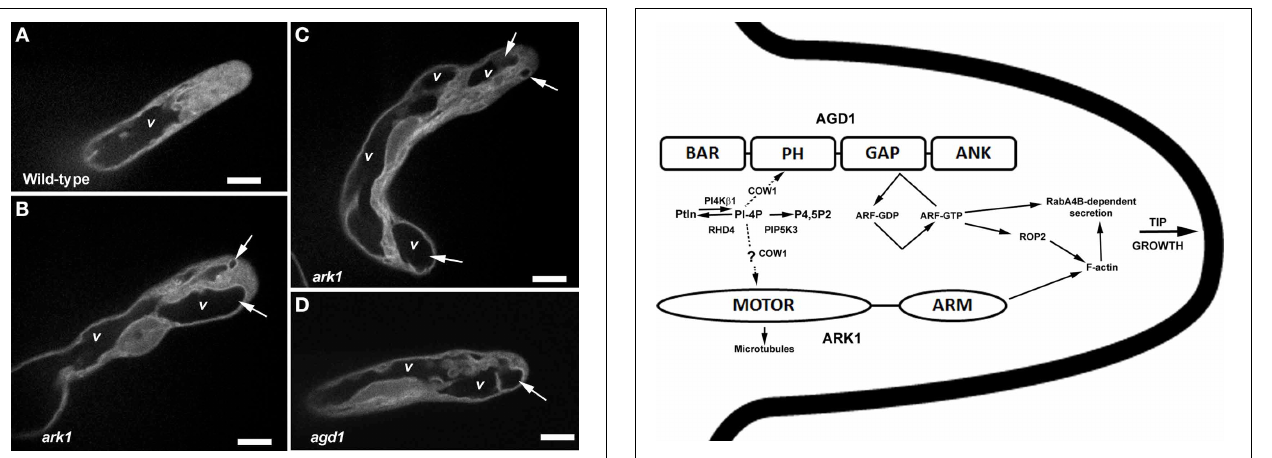
FIGURE 6 | Abnormal tonoplast organization at the growing apex was observed in ark1 and agd1 root hair cells. Tonoplast was visualized by expressing GFP-TIP in the plants. (A) In wild-type, the vacuole ( v ) is maintained at a distance from the extreme root hair apex. (B–D) In the ark1 and agd1 root hairs the vacuolar membranes occasionally protrude into the extreme apex (arrows). Time-lapse movie sequences of corresponding still images are presented as Movies S6 (for wild-type), S7 ( ark1 ), and S8 (for agd1 ). Bars = 20 μ m. actin and microtubules (Higaki et al., 2006; Oda et al., 2009),